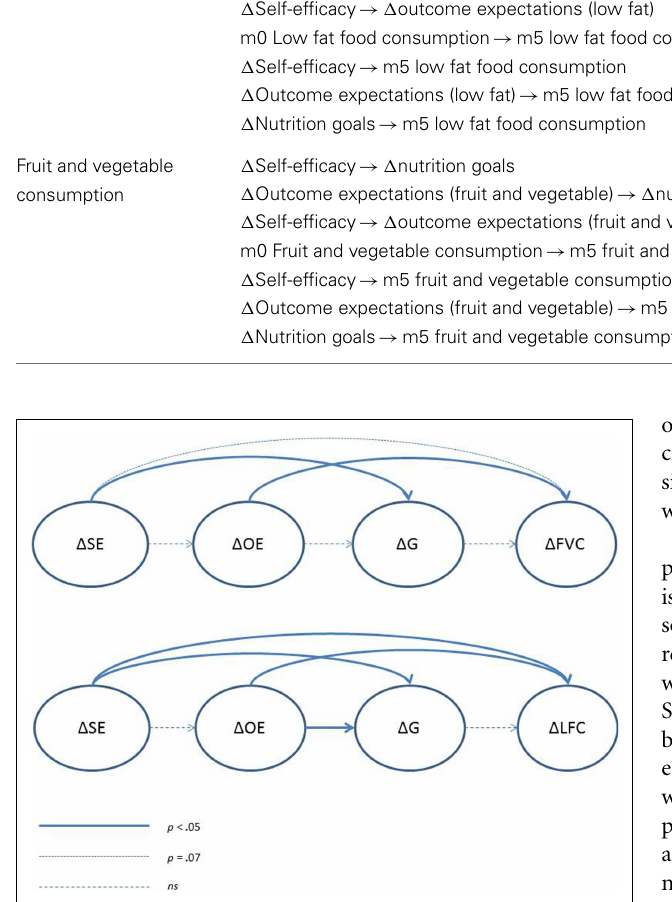
FIGURE 2 | Diagram of social cognitive determinants of change in dietary behavior over time . SE, self-efficacy; OE, outcome expectations; G, goals; FVC, fruit and vegetable consumption; LFC, low fat food